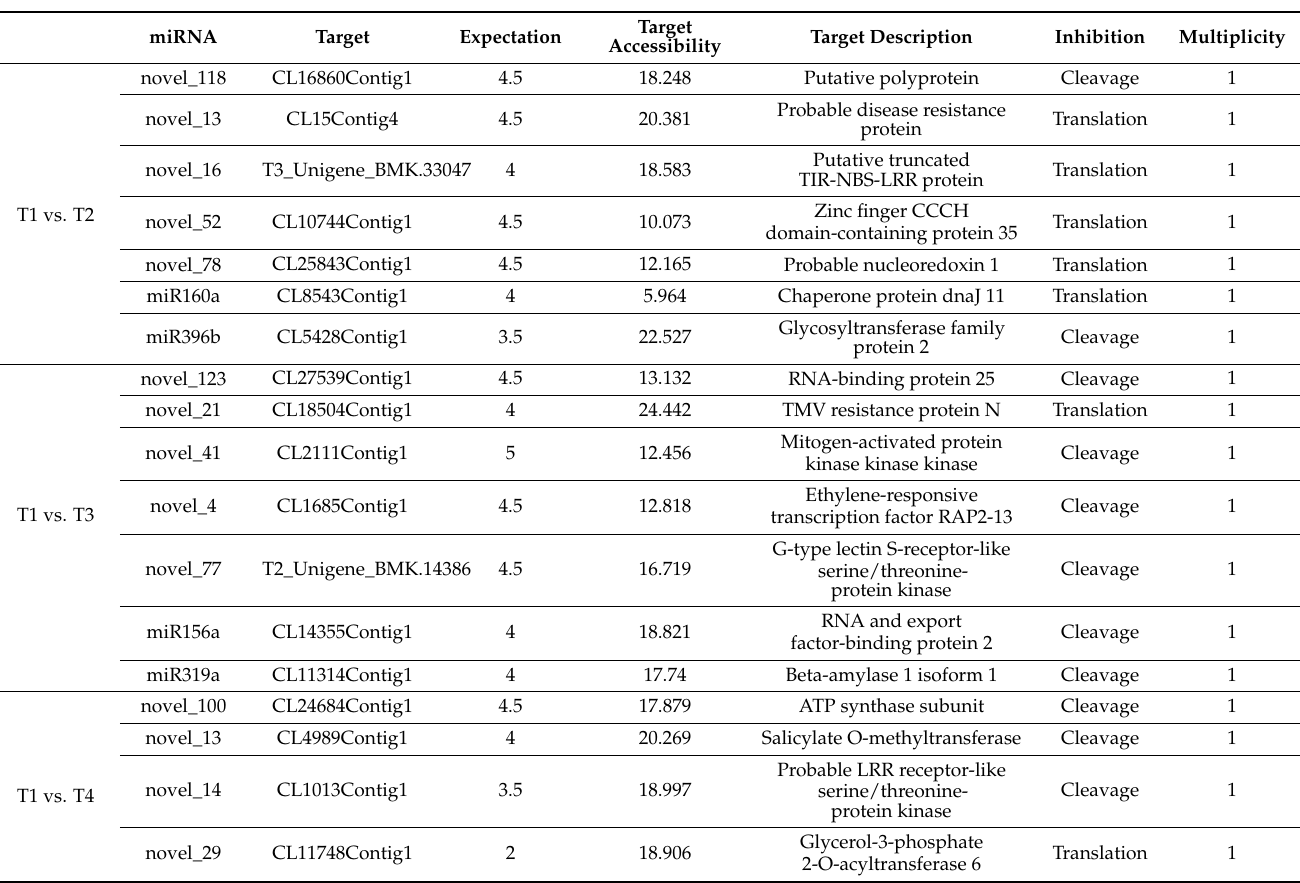
Table 3. Identified pairs of miRNAs and target genes with opposite expression patterns under salt